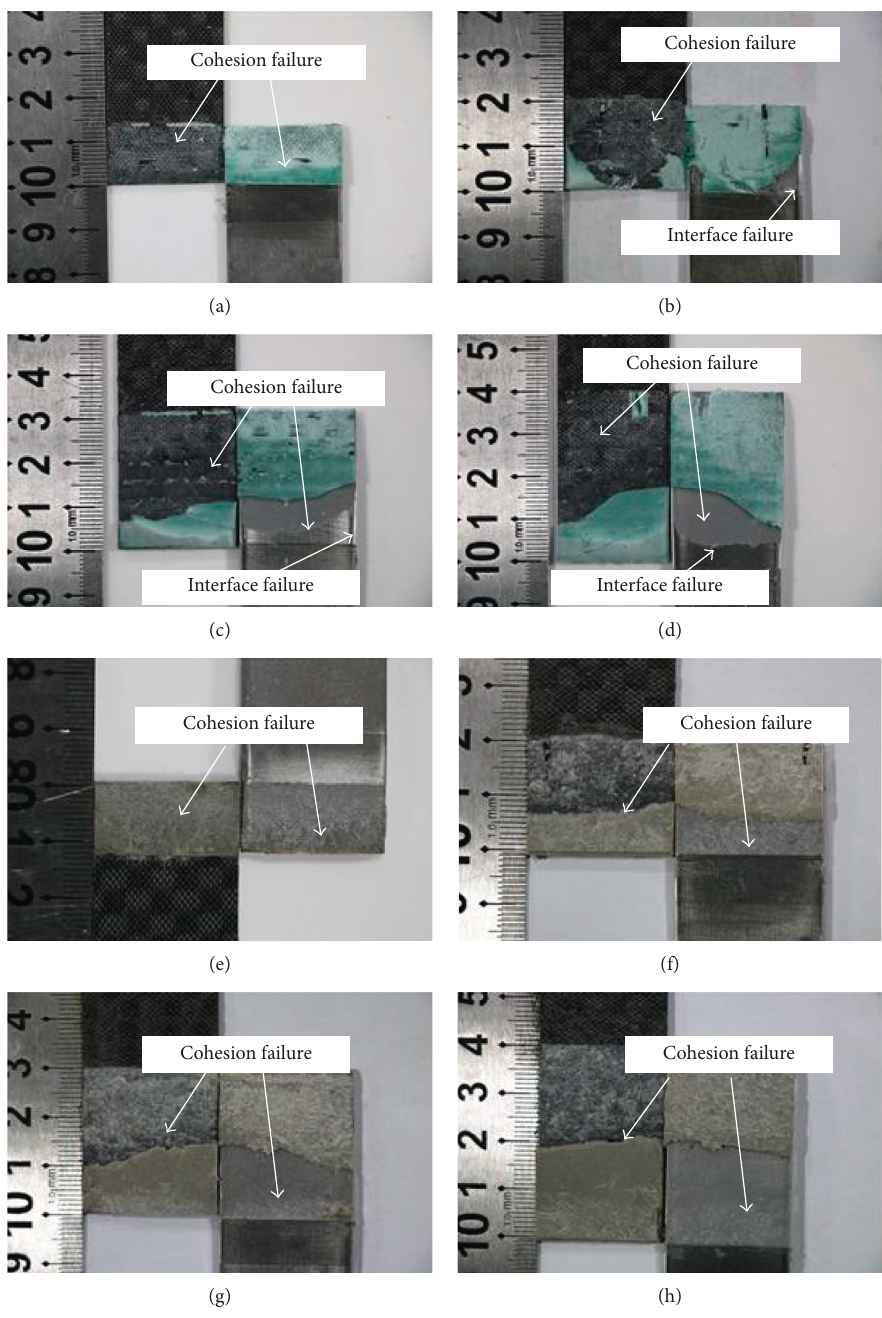
Figure 8: Failure models of 7779 adhesive joints with overlap lengths of (a) 12.5 mm, (b) 20mm, (c) 30mm, and (d) 40mm. Failure models of MA830 adhesive joints with overlap lengths of (e) 12.5 mm, (f) 20 mm, (g) 30 mm, and (h)